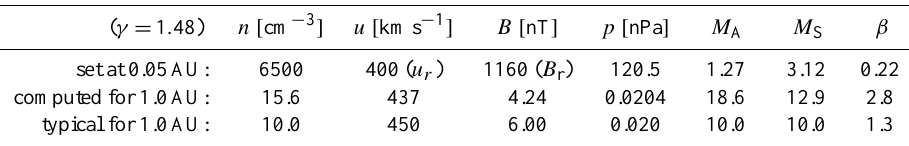
Table 1. Values set for the solar wind at the inner boundary at 0.05AU (1st row), values gained from the simulation at 1AU (2nd row), and typical quiet solar wind conditions (3rd